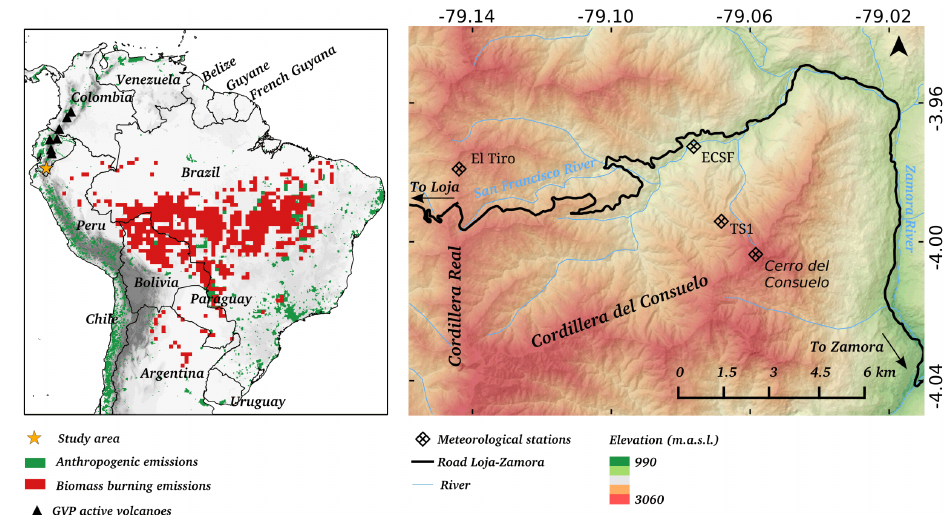
Figure 1. Study area. The left map shows possible anthropogenic and biomass-burning SO 2 sources in tropical South America and the location of active volcanoes in Ecuador and Colombia. The right map depicts the study area in the River San Francisco catchment and the location of the meteorological stations (MSs) involved in the